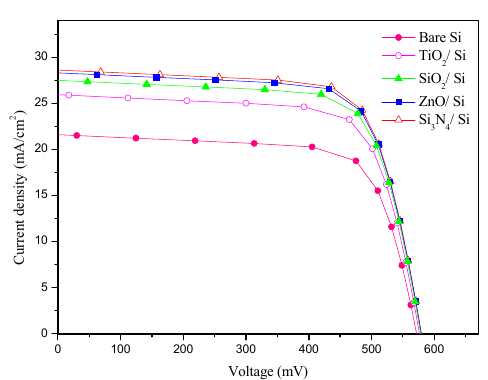
, SiO , Si N and ZnO ARC 2 2 3 4